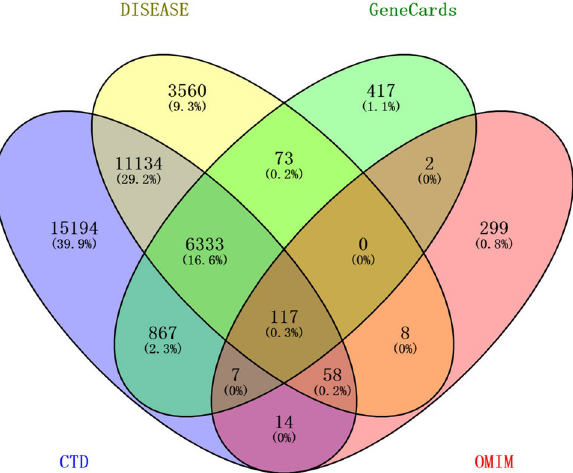
Figure 1. Venn Diagram of intersection between all the genes of HCC obtained from 4 public